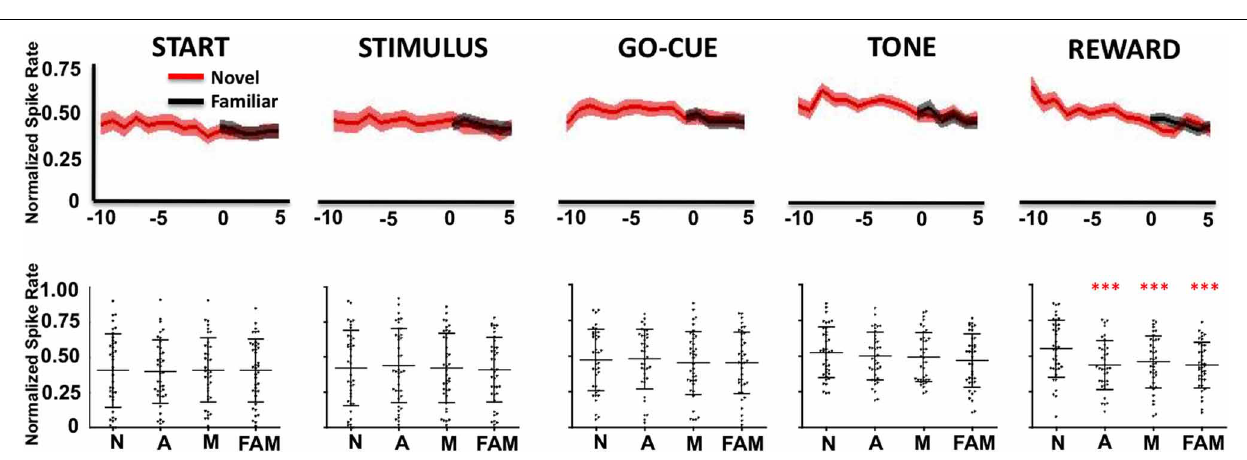
depicts the average normalized firing rate (mean ± SD) for each neuron (black dots) for familiar (FAM) and for novel objects when animals are naive (N; trials − 10 to − 7), acquiring (A; trials − 1 to 1) and after they have mastered (M; trials 3–5) the novel association ( ∗ p < 0 . 05, ∗∗ p < 0 . 01, and ∗∗∗ p < 0 . 001; Friedman repeated measures analysis of variance with Dunn’s correction).